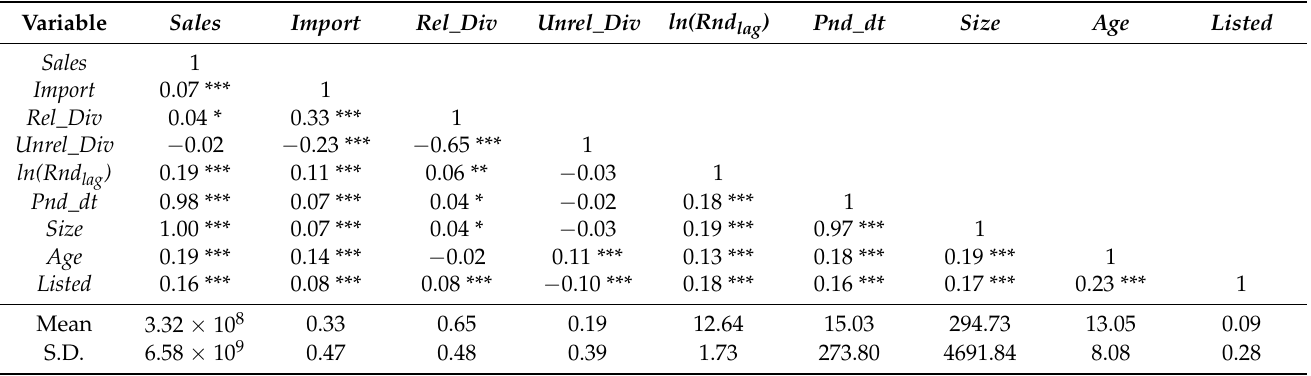
Table 4. Descriptive statistics and